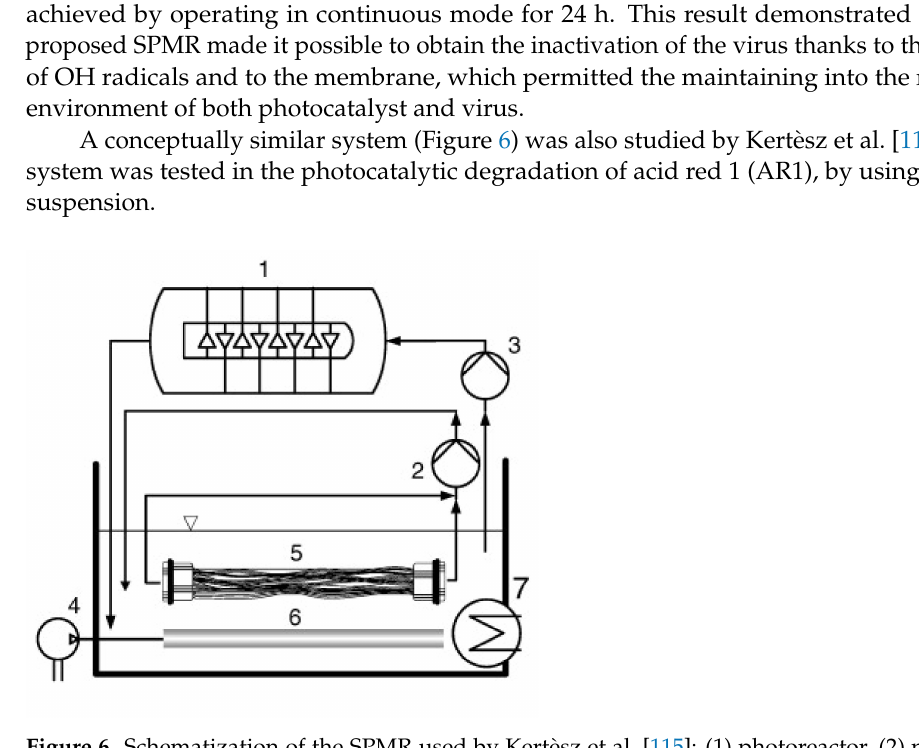
Figure 6. Schematization of the SPMR used by Kert è sz et al. [115]: (1) photoreactor, (2) permeate pump, (3) circulation pump, (4) air compressor, (5) hollow fiber membrane (HFM) module, (6) air diffuser, (7) temperature control system. Reprinted with permission from ref. [115]. Copyright © 2021 Elsevier